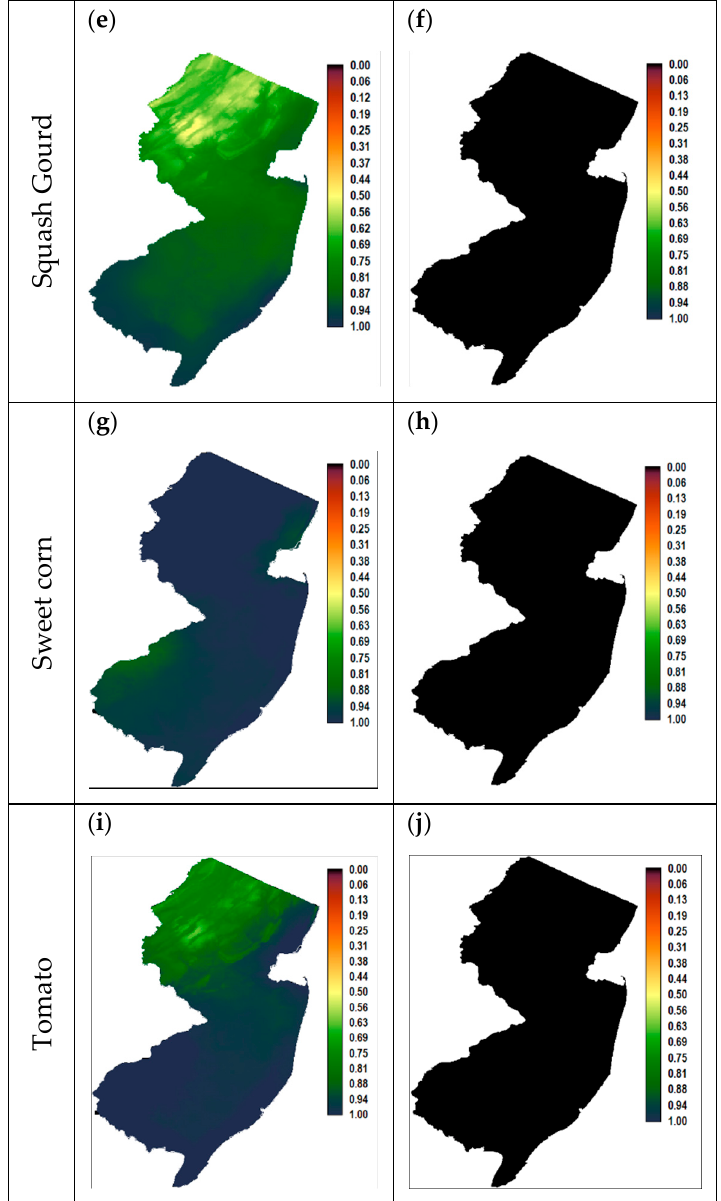
Figure 6. Changes to spatial distribution of areas suitable for production of selected crops from 30-year normal climatic conditions ( a , c , e , g , i ) and under A1FI-MI scenario by the end of the century ( b , d , f , h , j ). The suitability of the five crops varies from 0 to 1. It is represented by colors varying from dark green color (highly suitable) and the black color representing the very marginal suitability. (Refer to the legend to the right for related numerical detail)